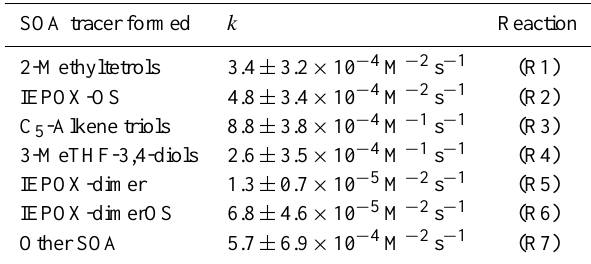
Table 3. Model-predicted formation reaction rate constants for IEPOX-SOA